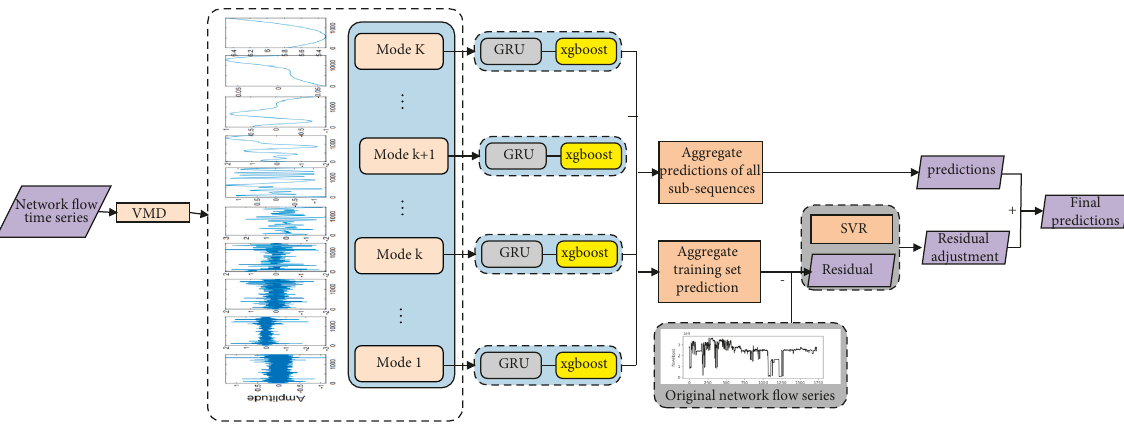
Figure 2: The flowchart of the proposed